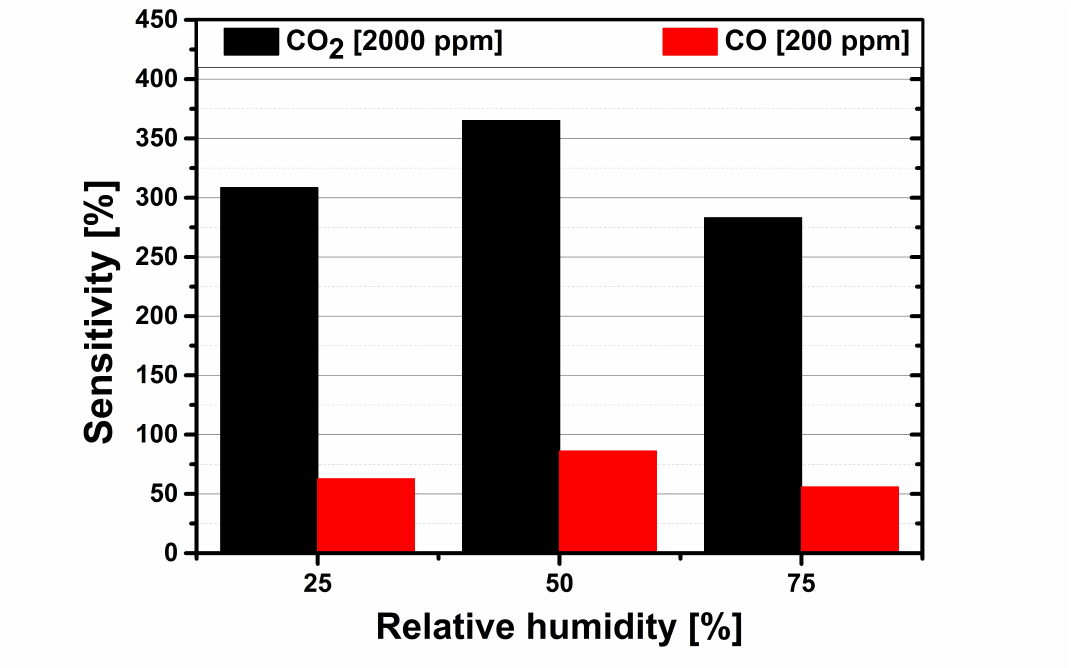
Figure 10. Comparison of the Au-NPs functionalized gas sensors sensitivities towards a 2000 ppm CO 2 gas pulse (black bars) and a 200 ppm CO gas pulse (red bars) at relative humidity levels of 25%, 50% and 75% at an operation temperature of 300 ◦